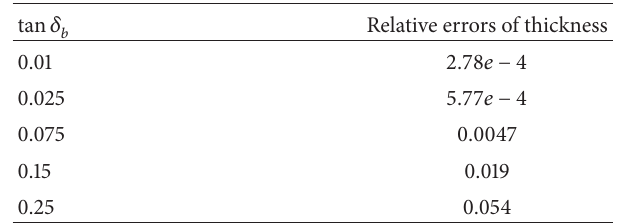
Table 11: Influence of tan 𝛿 𝑏 on the radome’s